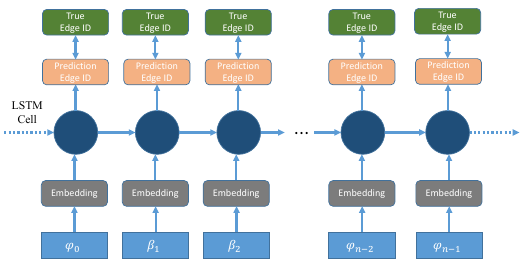
Figure 6. RNN with multiple outputs.